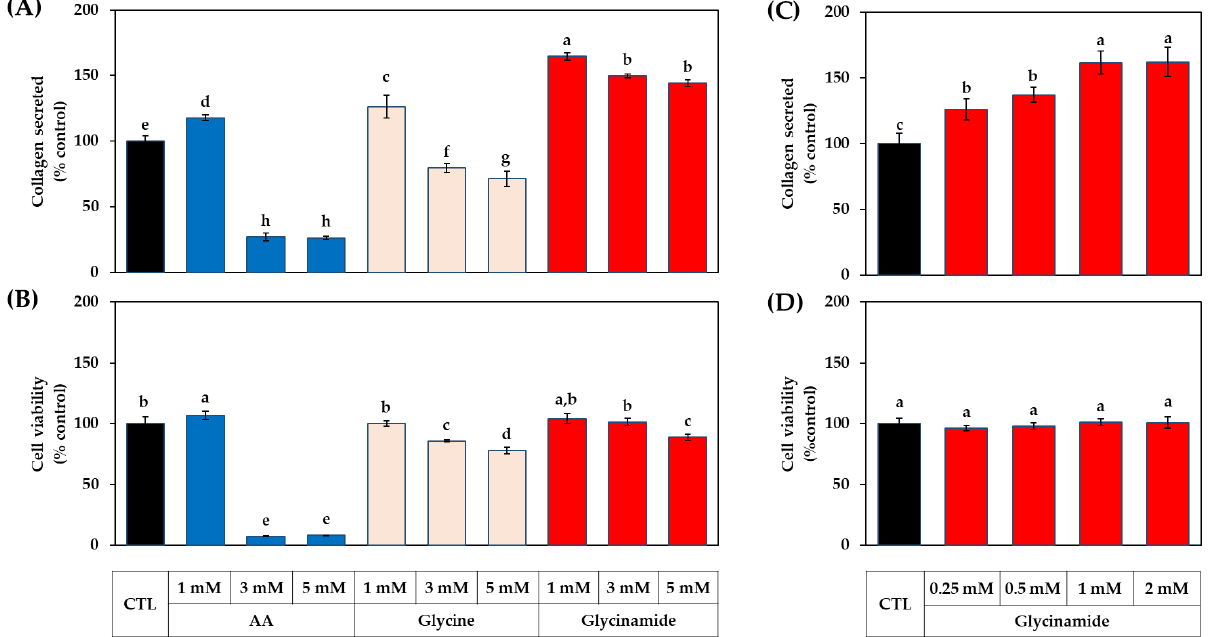
Figure 4. Dose-dependent effects of AA, glycine, and glycinamide on the collagen production of HDFs. Cells were treated with vehicle (CTL) or 1 – 5 mM of each compound ( A , B ) or 0.25 – 2 mM of glycinamide ( C , D ). After 48 h, the collagen protein secreted into the conditioned medium was quantitated ( A , C ). The viability of the adherent cells was determined ( B , D ). Data are presented as % of control (means ± SD, n = 3 for ( A – C ), and n = 4 for ( D )). Groups that share the same alphabet letters (a – h) do not have significantly different means at the p < 0.05 level.